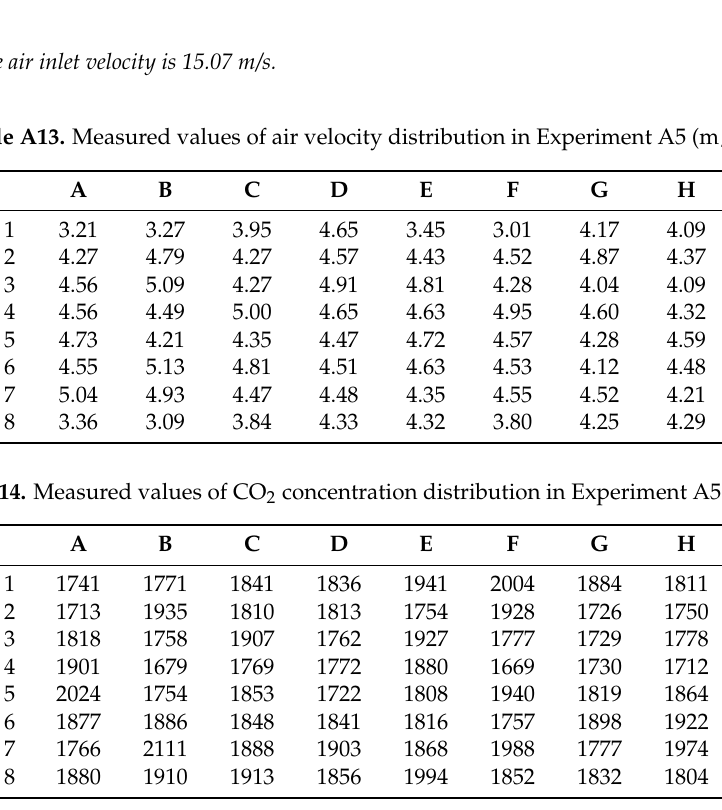
Table A12. Pressure loss in Experiment A4 (Pa). Item Measurement Value Total pressure loss 641 Pressure loss (catalysts excluded) 251